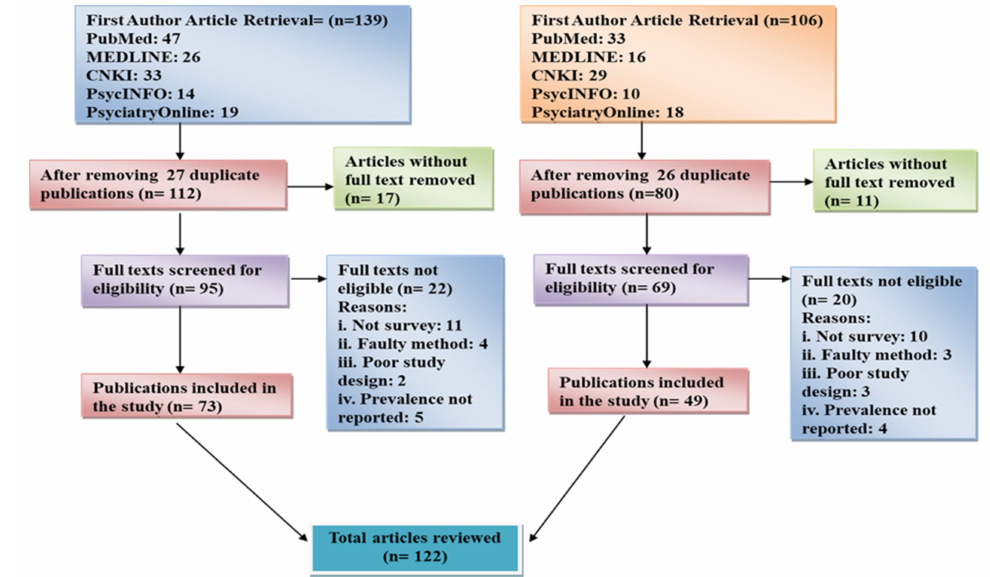
Figure 3. Articles retrieval and screening